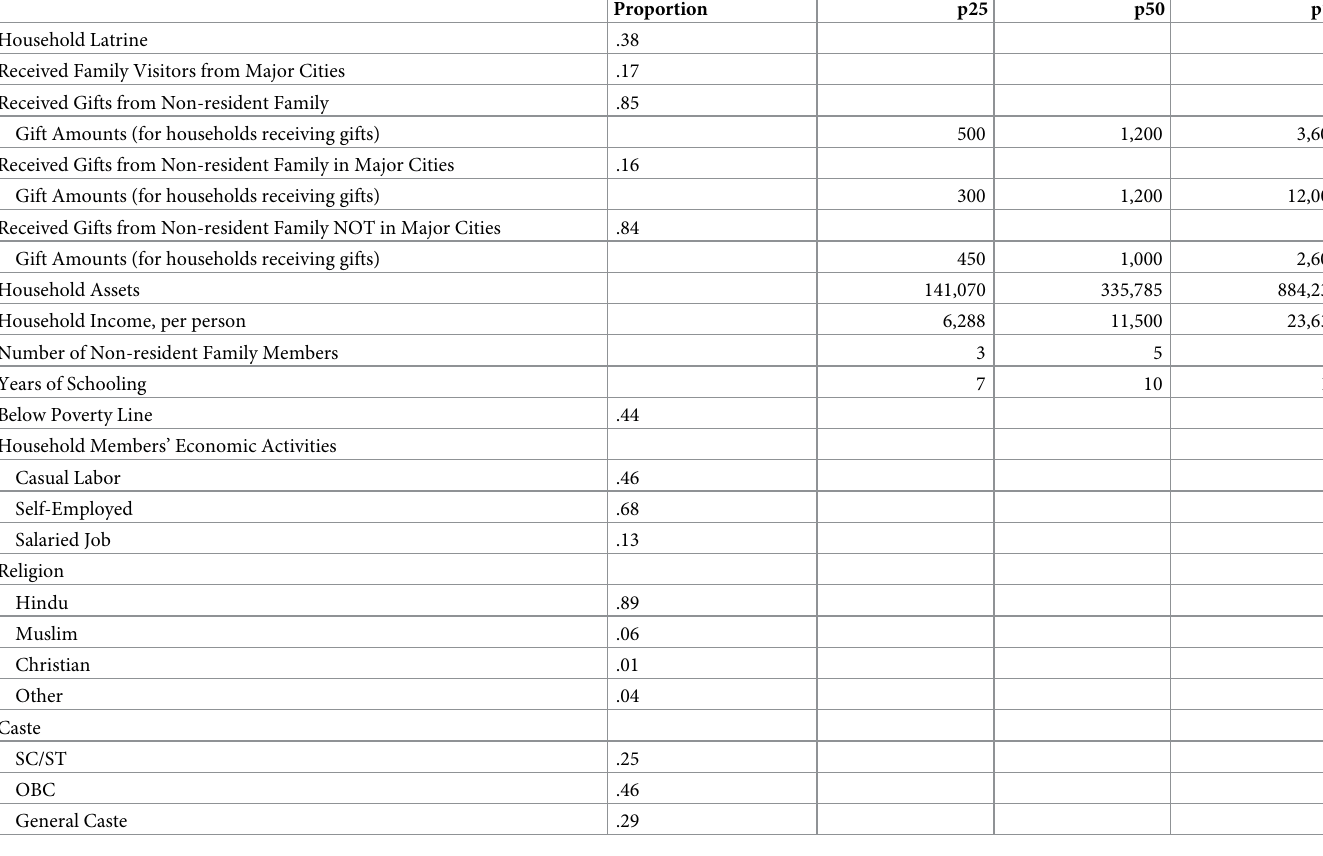
Table 1. Descriptive statistics of analytic